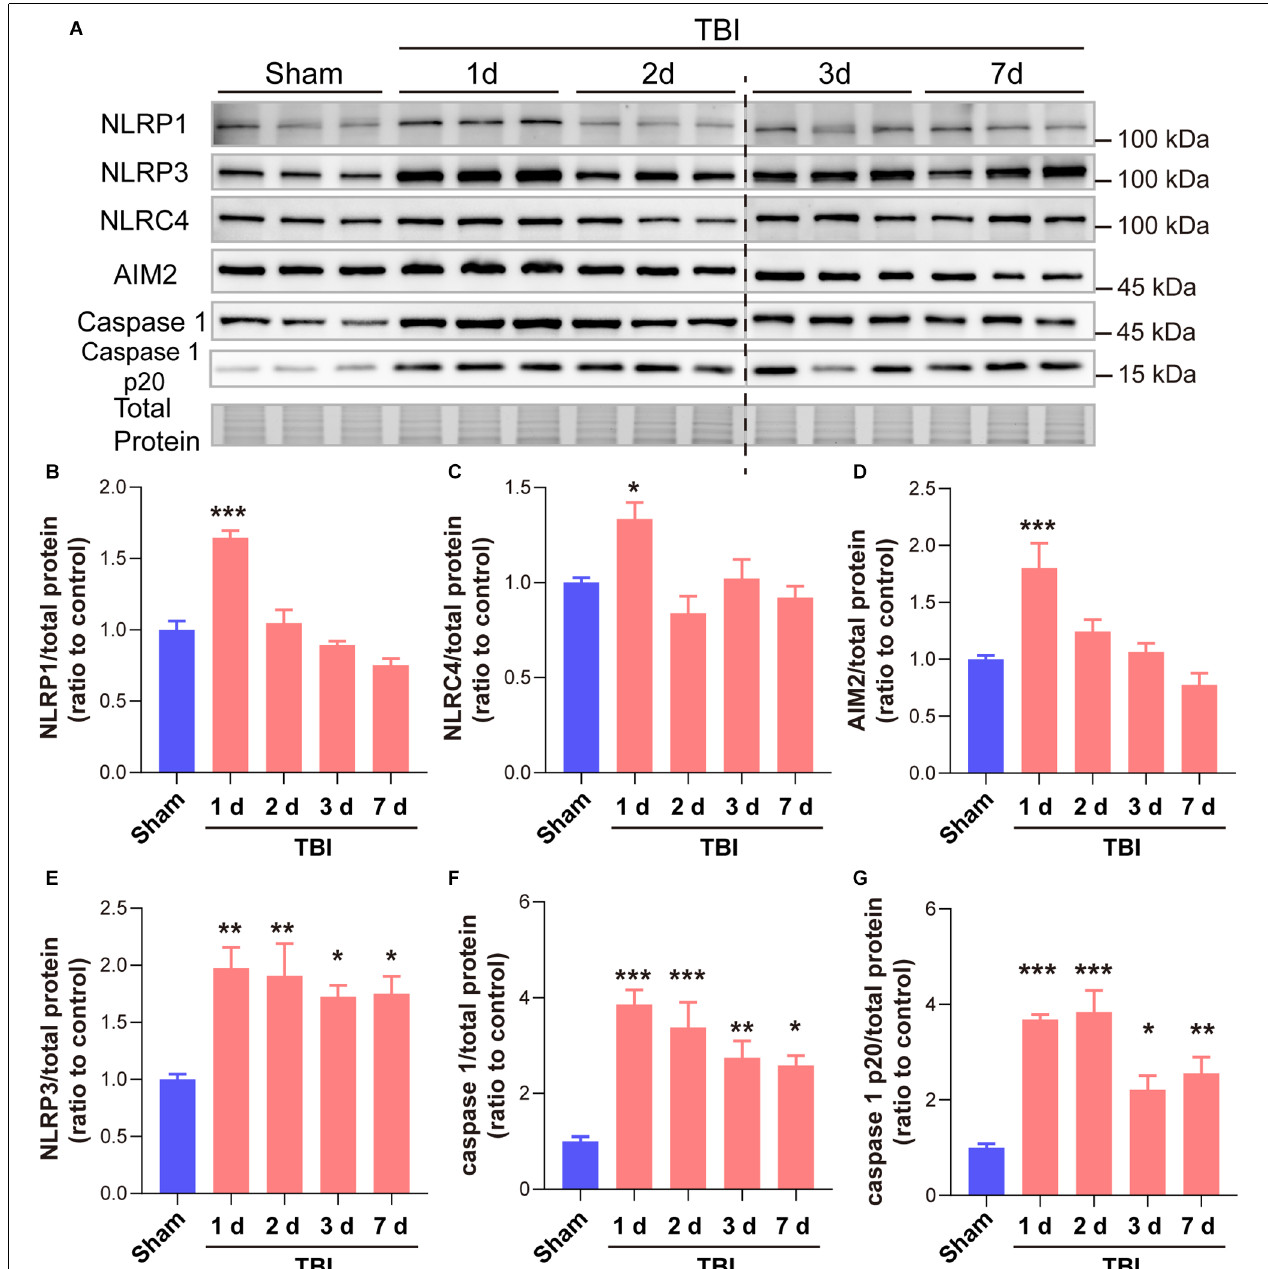
FIGURE 5 | GSDMD cleavage after TBI was mainly driven by the NLRP3 inflammasome rather than the NLRP1, NLRC4, and AIM2 inflammasomes. (A) Representative immunoblots images of NLRP1, NLRP3, NLRC4, AIM2, caspase 1, caspase 1 p20, and total protein. (B–G) Quantitative analysis of NLRP1, NLRC4, AIM2, NLRP3 caspase 1, and caspase 1 p20 levels ( n = 6). All data are presented as the mean ± SEM and were analyzed using one-way ANOVA followed by Tukey’s multiple comparisons test for significance. * p < 0.05, ** p < 0.01, and *** p < 0.001.